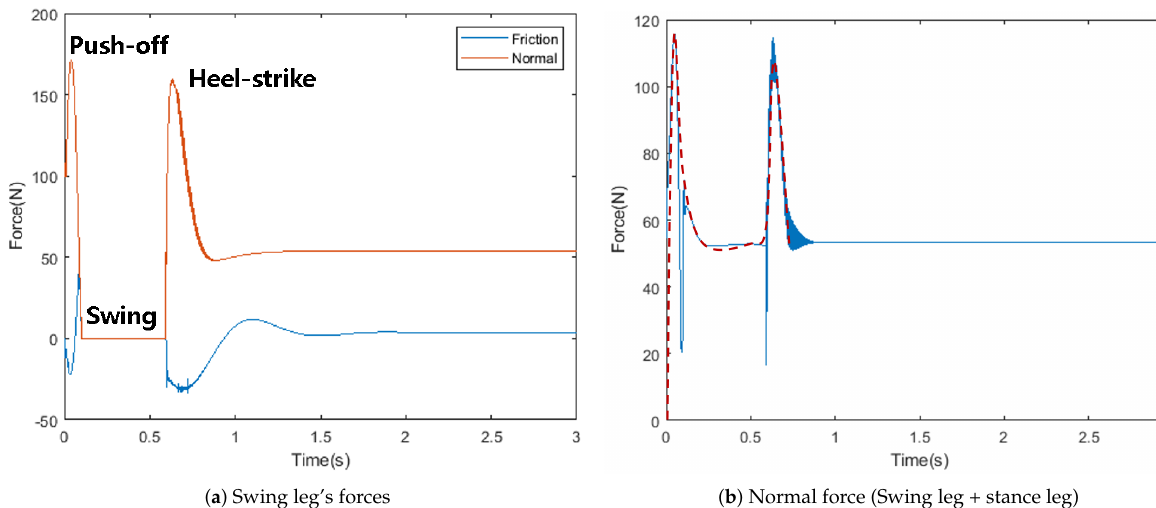
Figure 17. Normal and friction force of one step simulation. Red dashed line: approximation of